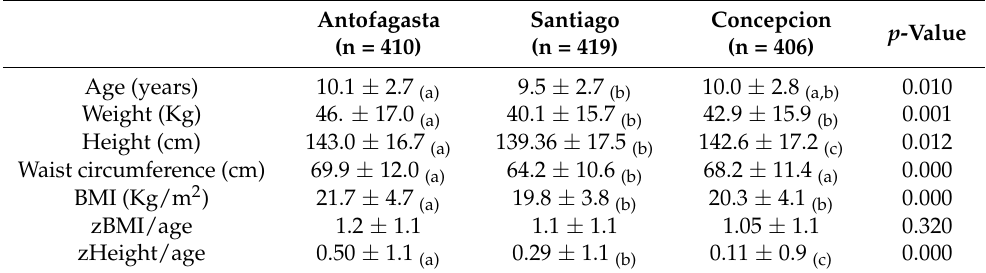
Table 1. Physical characteristics of children by city.